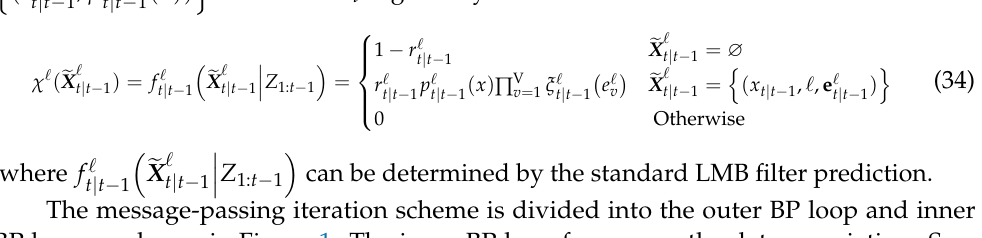
Figure 3. An illustration of the factorization of f used with J = | L t | , χ (cid:96) (cid:44) χ (cid:96) ( (cid:101) X β (cid:96) v = β (cid:96) v ( a t , v ( (cid:96) )) , η (cid:96) v = η (cid:96) v ( a t , v ( (cid:96) )) , γ (cid:96) v (cid:44) γ (cid:96) v ( (cid:101) X Ψ ( a s ( (cid:96) )) , b t , v ( m )) t , v ( a t